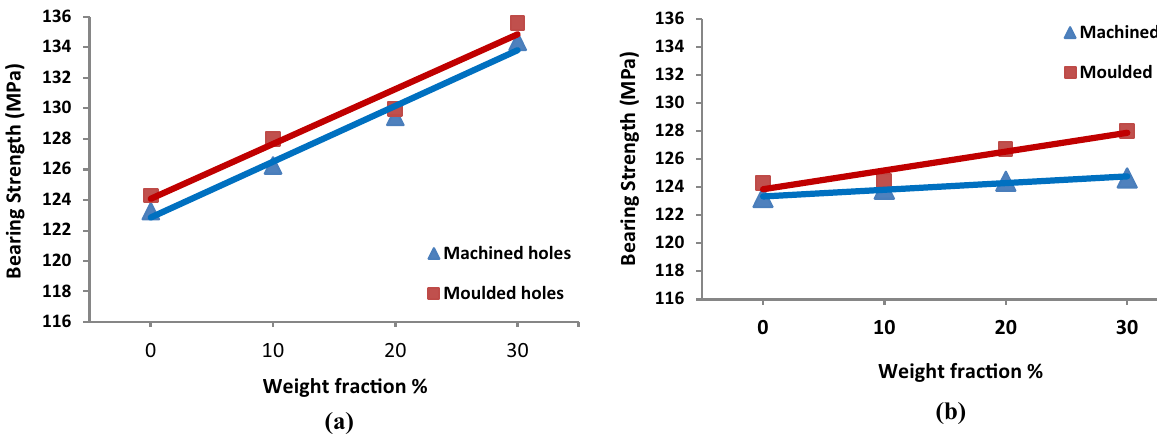
Figure 8. BS of molded-in holes vs. machined holes; ( a ) LFPP, ( b ) SFPP.